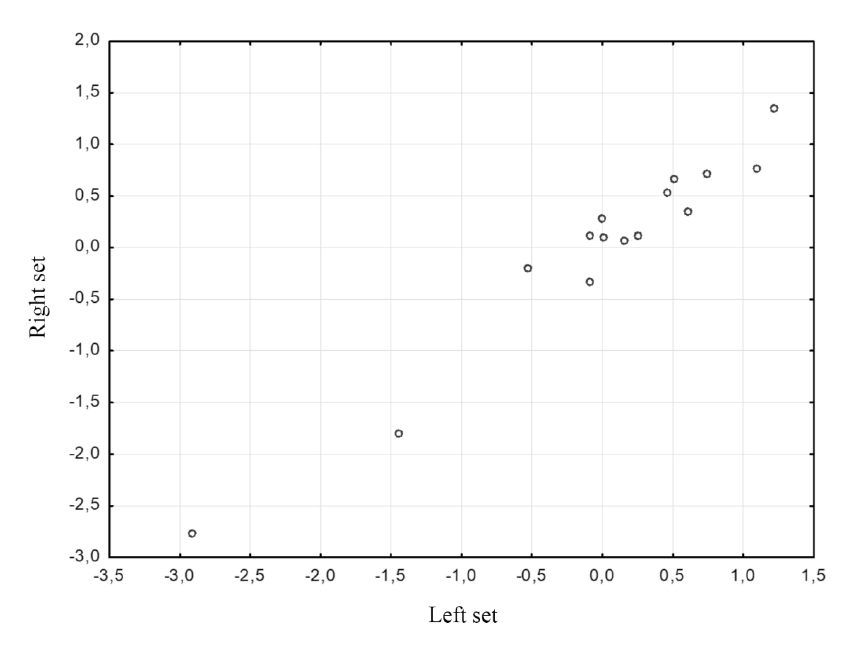
Figure 3. Scatter diagram of canonical correlations for the first canonical root